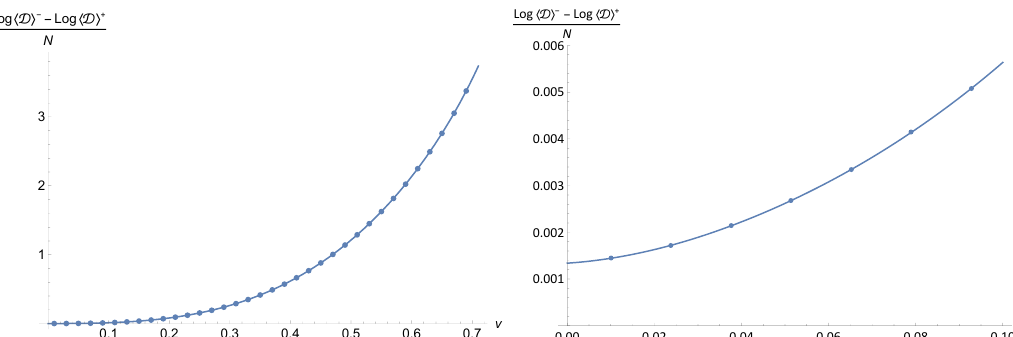
Figure 7. The difference in the defect expectation value between the theories with ∆ − and ∆ + boundary condition in d = 3 . 9 . Note that for ∆ − boundary condition, as discussed below (4.25), there is a nontrivial defect also at v = 0 , so the difference in the expectation value should be nonzero at v = 0 . This becomes clear when we zoom in to the region near v = 0 which is what we show on the right